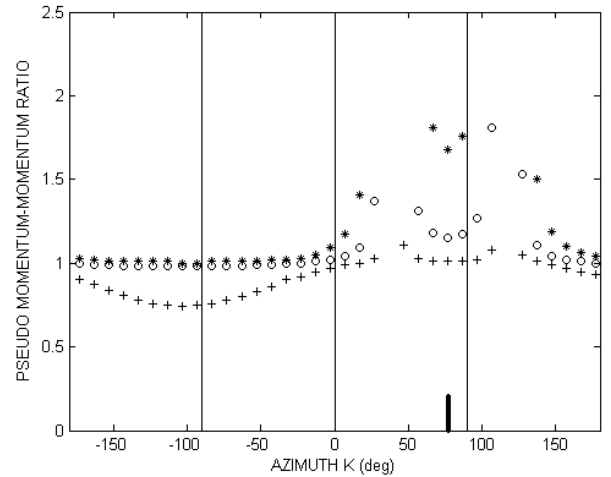
Fig.B2 The amplitude ratio between the horizontal pseudo momentum and the Fig. B2. The amplitude ratio between the horizontal pseudo mo- .(cid:12) (cid:12) rr ˜ P (cid:12) (cid:12) ) as function of the mentum and the momentum (ratio= | P h | momentum ( ratio P P = % ) as function of the azimuth angle of the h (cid:12) (cid:12) h h (cid:16) ˜ (cid:17) azimuth angle of the corresponding AGW. Cross: v ph = 30m/s P x , ˜ P y ; and τ = 45 min; Open circle: v ph = 30m/s and τ = 143 min; Star: corresponding AGW. ‘ Cross’: 30 v m s = and 45min τ= ; ‘Open circle ’: ph v ph = 30m/s and τ = 300 30 v m s = and 143min τ= ; ‘Star ’: 30 v m s = and 300min τ= . ph ph